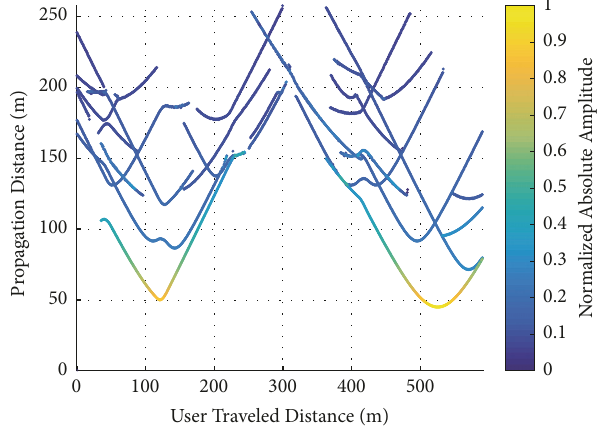
Figure 7: The results of the KEST estimator for the simulations showing the propagation distances of signal components versus the user traveled distance. The propagation distances are the ToA multiplied by the speed of light. Only signal components that are observable for a traveled distance of at least 35 m are shown. The color indicates the normalized amplitude in linear domain. END, respectively. The traveled distances of the user are marked for every 50